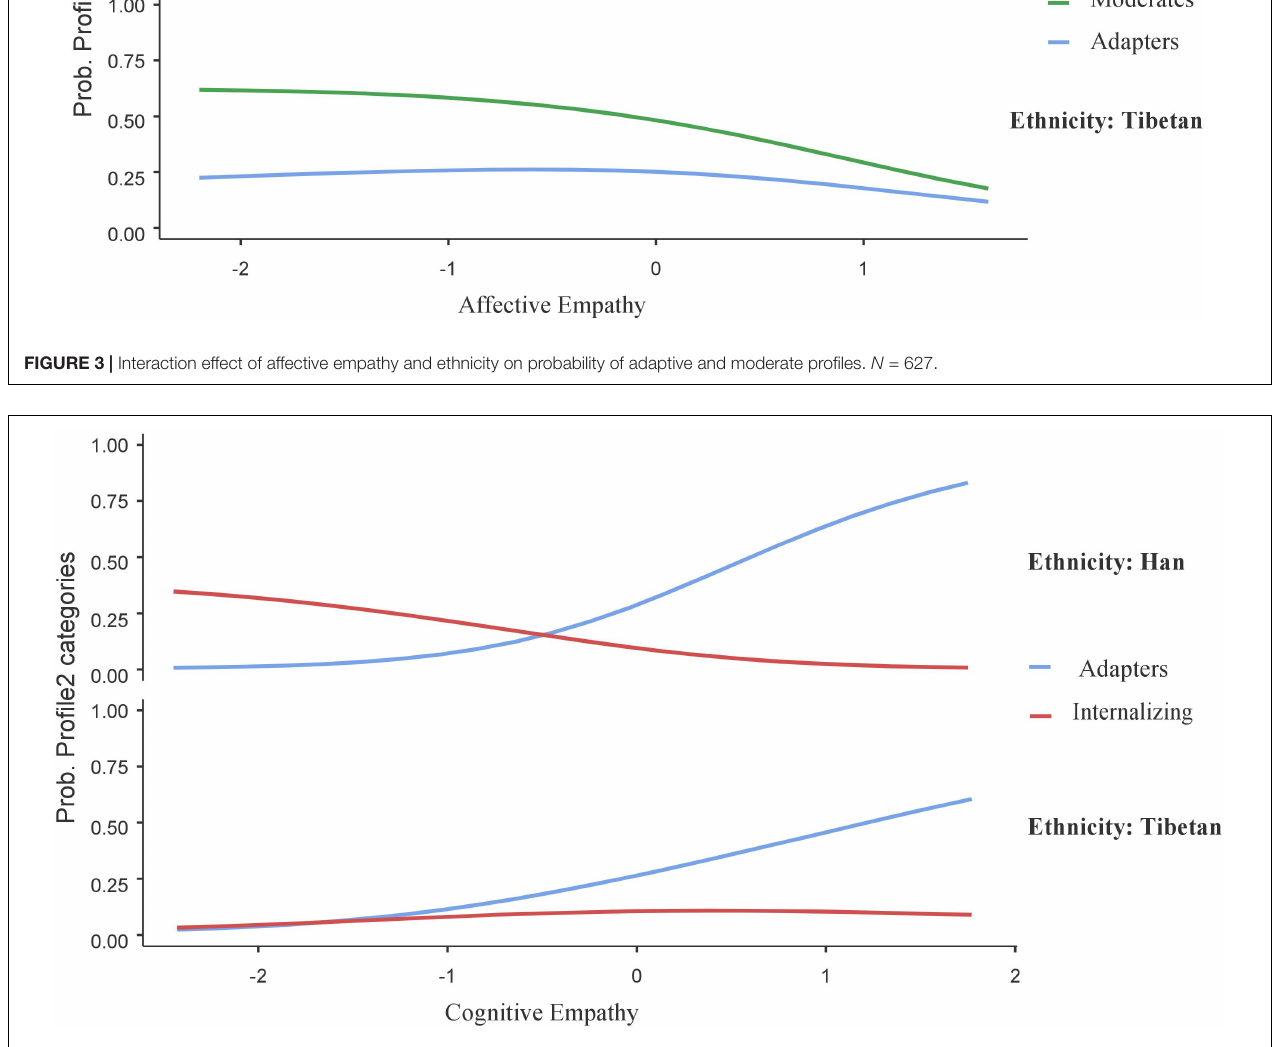
FIGURE 4 | Interaction effect of cognitive empathy and ethnicity on probability of adaptive and internalizing profiles. N =